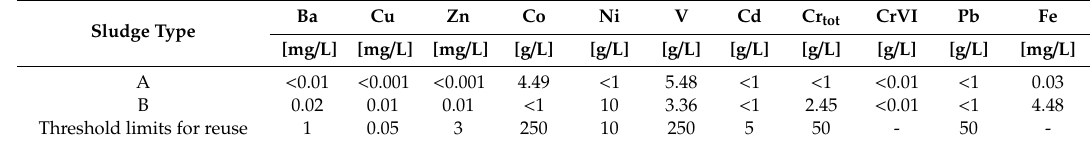
Table 5. Results of leaching tests performed on sawing sludge (threshold limits defined in [41]). Ba Sludge Type